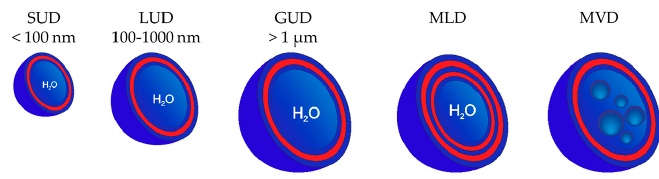
Figure 6. Classification of vesicles according to their size and number of bilayers.